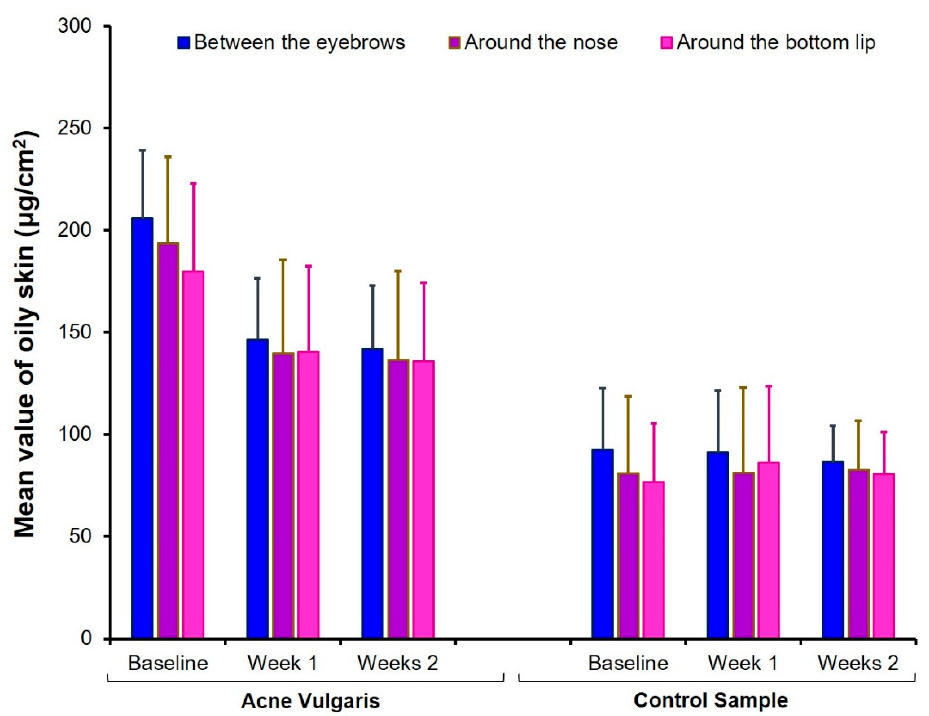
Figure 6. Comparison of mean values of oily skin at baseline, one week, and two weeks after finishing the treatment with hydrogen purification in both AV and CS groups. Error bars are standard deviations.